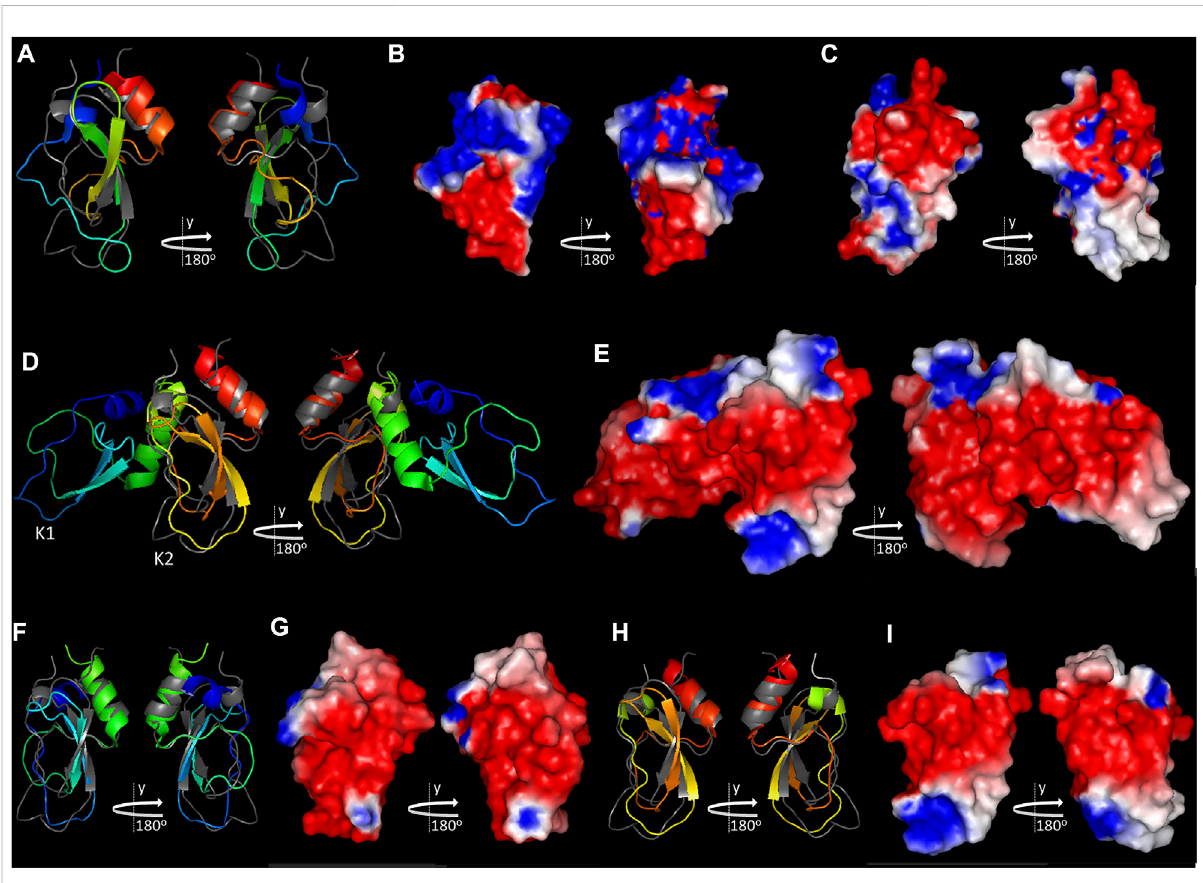
Comparison of Amblyomin-X ’ s KD with TAP and Ixolaris. Amblyomin-X ’ s KD homology model (colored gray in A and E, in the same orientation asFigure2A)wasalignedwithNMRstructuresofTAP(PDB:1TCP) (A) ,Ixolaris(PDB:6NAN) (D) ,andIxolarisK1 (F) ,andK2 (H) ,coloredinrainbow(blue to red). Electrostatic potential of the molecular surfaces of (B) TAP, (C) KD of Amblyomin-X, (E) Ixolaris, (G) Ixolaris K1, and (I) Ixolaris K2 are shown. Structure visualizations were created in PyMOL